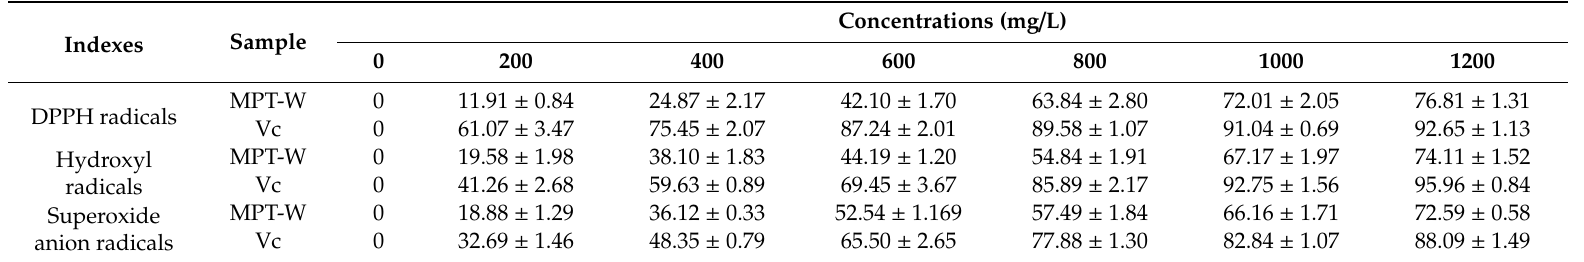
Table 2. Antioxidant activities in